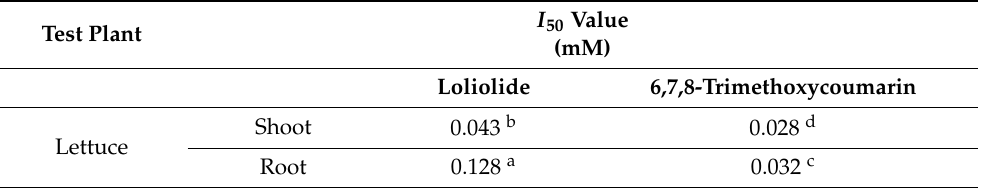
Figure 6. Effects of the loliolide treatment on the growth (shoot and root) of lettuce seedlings. Mean ± SE of each experiment replicated 3 times ( n = 30). Differences between the control and treatment are represented by different letters (Tukey’s HSD at p ≤ 0.05). Table 2. The I 50 values of loliolide and 6,7,8-trimethoxycoumarin characterized from T. nudiflora leaf extracts for lettuce shoot and root growth